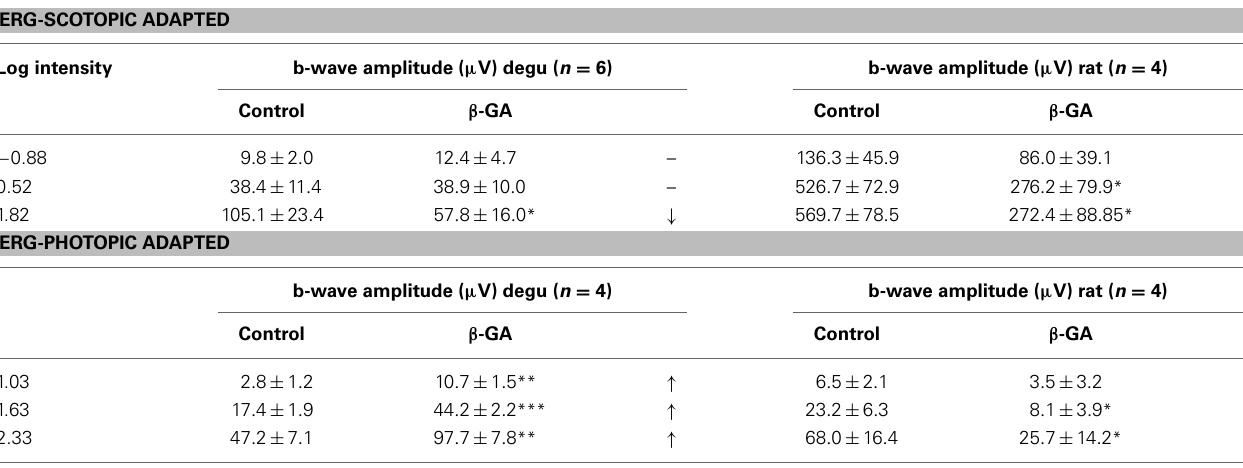
Table 1 | Summary of the effects of β -GA on the ERG parameters (mean ± s.e.m.) in degu and rat. ERG-SCOTOPIC